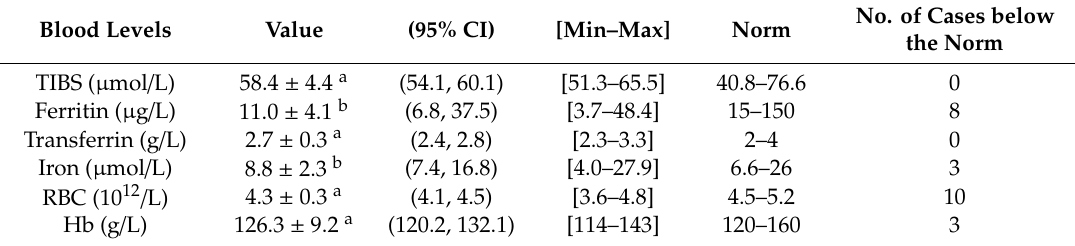
Table 6. Haematology profile and serum ferritin, transferrin, iron, and TIBS concentrations in deaf athletes. Blood Levels Value (95%